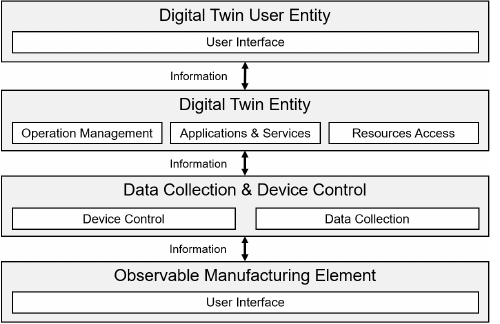
Figure 1. Digital twin framework based on the description in the ISO 23247 standard. [Source: Own figure based on the International Organization for Standardization (ISO) illustration in